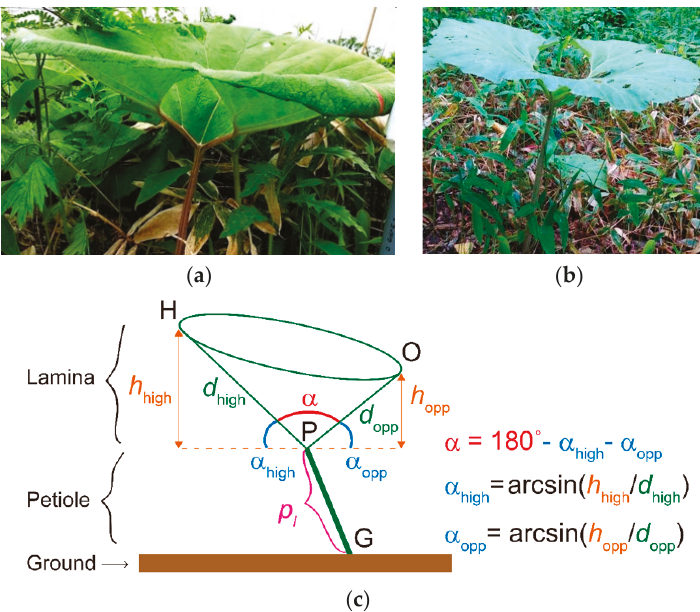
Figure 1. The measured morphological parameters of the leaves of the butterburs ( Petasites japonicus (Siebold et Zucc.) Maxim. subsp. giganteus (G.Nicholson) Kitam.) investigated in this study. Leaves in ( a ) the clearing and ( b ) the understory, in addition to ( c ) the measured leaf parameters, are shown. H: The highest point on the leaf lamina. O: The point located at the opposite side of H on the lamina edge. P: The point of attachment of the lamina to the petiole. G: The point of attachment of the petiole to the ground. d high : The distance between H and P. h high : The vertical distance between H and P. d opp : the distance between O and P. h opp : the vertical distance between O and P. p l : Above-ground petiole length (the distance between P and G). α : Lamina openness angle. Photographs were taken in June 2020 by Kohei Koyama.